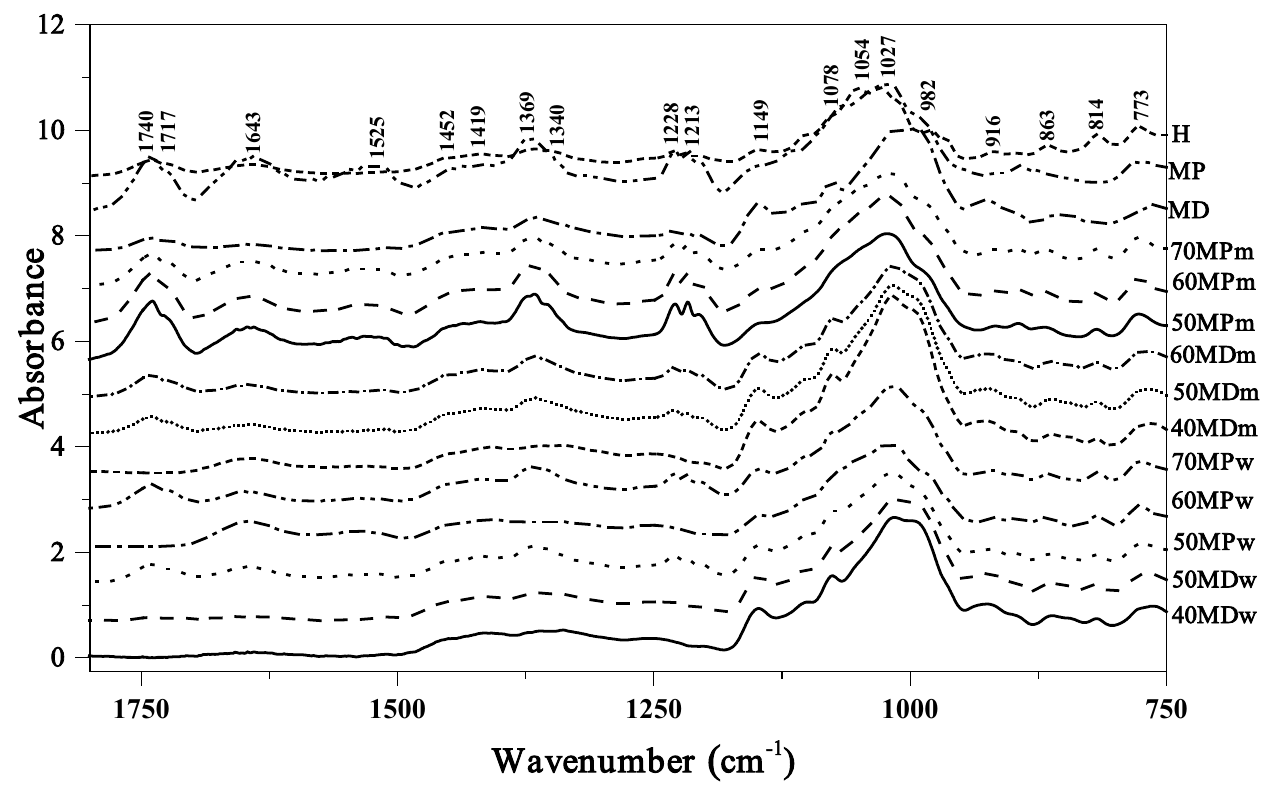
Figure 1. FTIR spectra for different samples of honey and basic materials. All spectra were normalized at the 3290 cm − 1 . Table 2. The location of the maxima of absorption bands FTIR with arrangement of appropriate vibrations selected for maltodextrin (MD), skim milk powder (MP), and multifloral honey (H) made in terms of spectral 3900–700 cm − 1 .